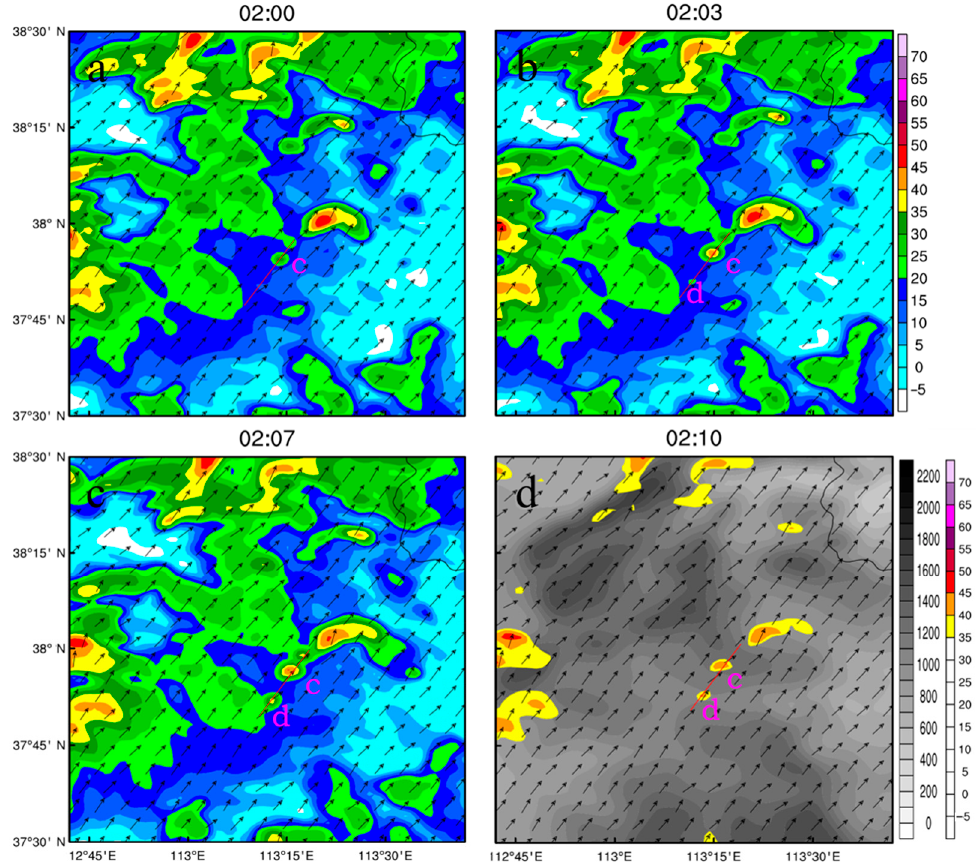
Figure 11. ( a – c ) Simulated composite radar reflectivity (shaded, units: dBZ) and the wind field (vector arrows, units: m s − 1 ) at 700 hPa at 0200, 0203, and 0207 UTC 21 July 2012, respectively. The letters “c” and “d” denote convective cells over the mountains. ( d ) As in ( a – c ) but the composite radar reflectivity (color shaded, units: ≥ 35 dBZ) and the topographic height (gray shaded, units: m).